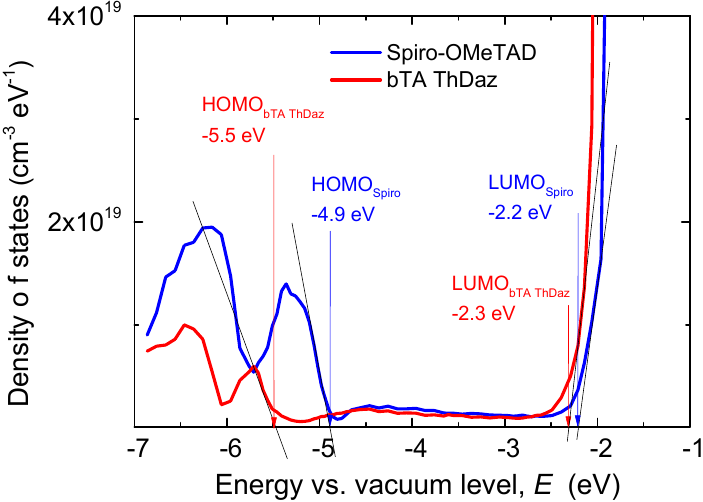
Figure 5. ER-EIS spectra in linear scale measured on imine bTaThDaz and spiro -OMeTAD thin films in acetonitrile with 0.1 M TBAF 6 . The frontier orbitals (HOMO and LUMO) were determined from the intersect of the of band tail extrapolation to the energy scale.